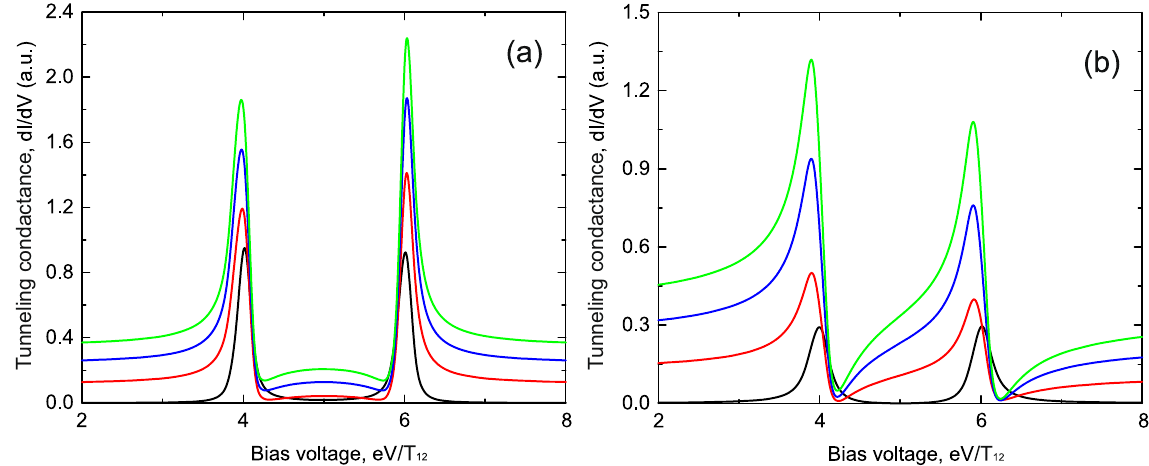
Figure 6. (Color online) Tunneling conductance as a function of applied bias voltage for the impurities configuration shown in Fig. 3b in the case of the intermediate system formed by a chain of two impurity atoms. (a) Demonstrates results in the absence of Coulomb interaction; (b) shows calculation results in the presence of infinitely large Coulomb interaction. Black curves correspond to the tunneling rates t L 1 = t R 2 = 0.3 T 12 , T = 0.0 ; red curves correspond to the tunneling rates t L 1 = t R 2 = 0.3 T 12 , T = 0.6 T 12 ; blue curves correspond to the tunneling rates t L 1 = t R 2 = 0.3 T 12 , T = 1.0 T 12 ; green curves correspond to the tunneling rates t